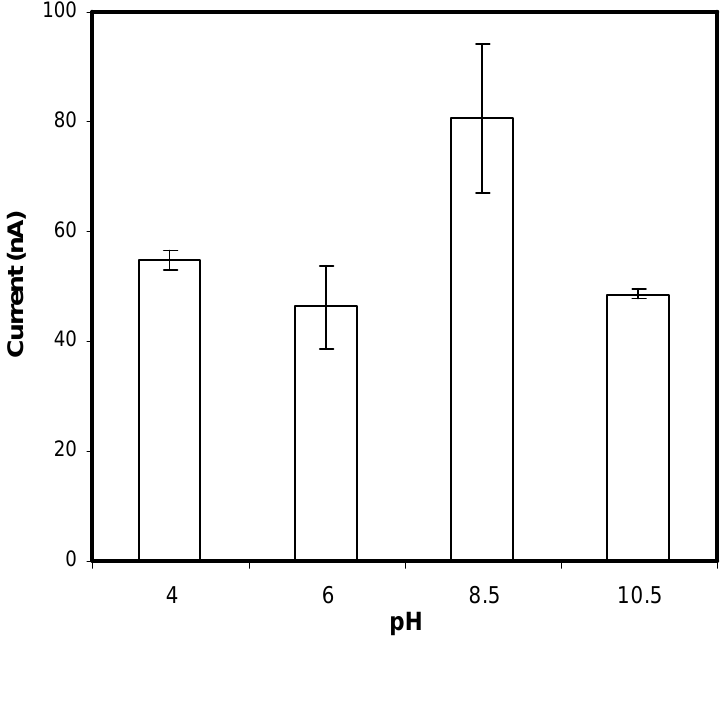
Figure 5. The effect of pH on the response of the biosensor containing Fe nanoparticles. The substrate concentration of AA2P for the study was fixed at 80 µM in 0.1 M Tris-HCl buffer with applied potential at 0.6 V versus Ag/AgCl